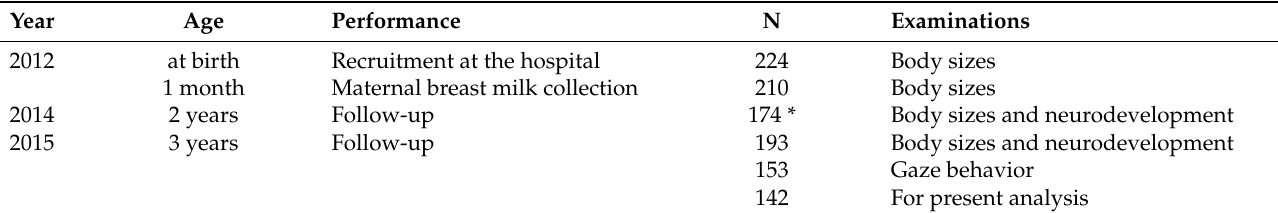
Table 1. Summary of Bien Hoa birth cohort